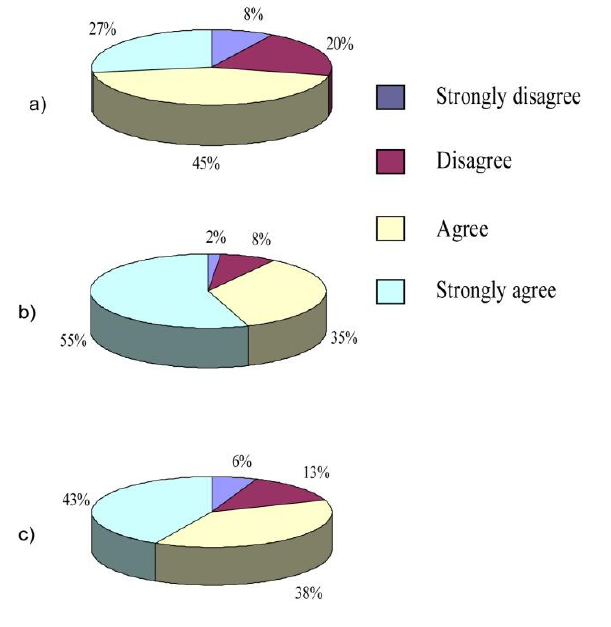
Fig. 3. Results of